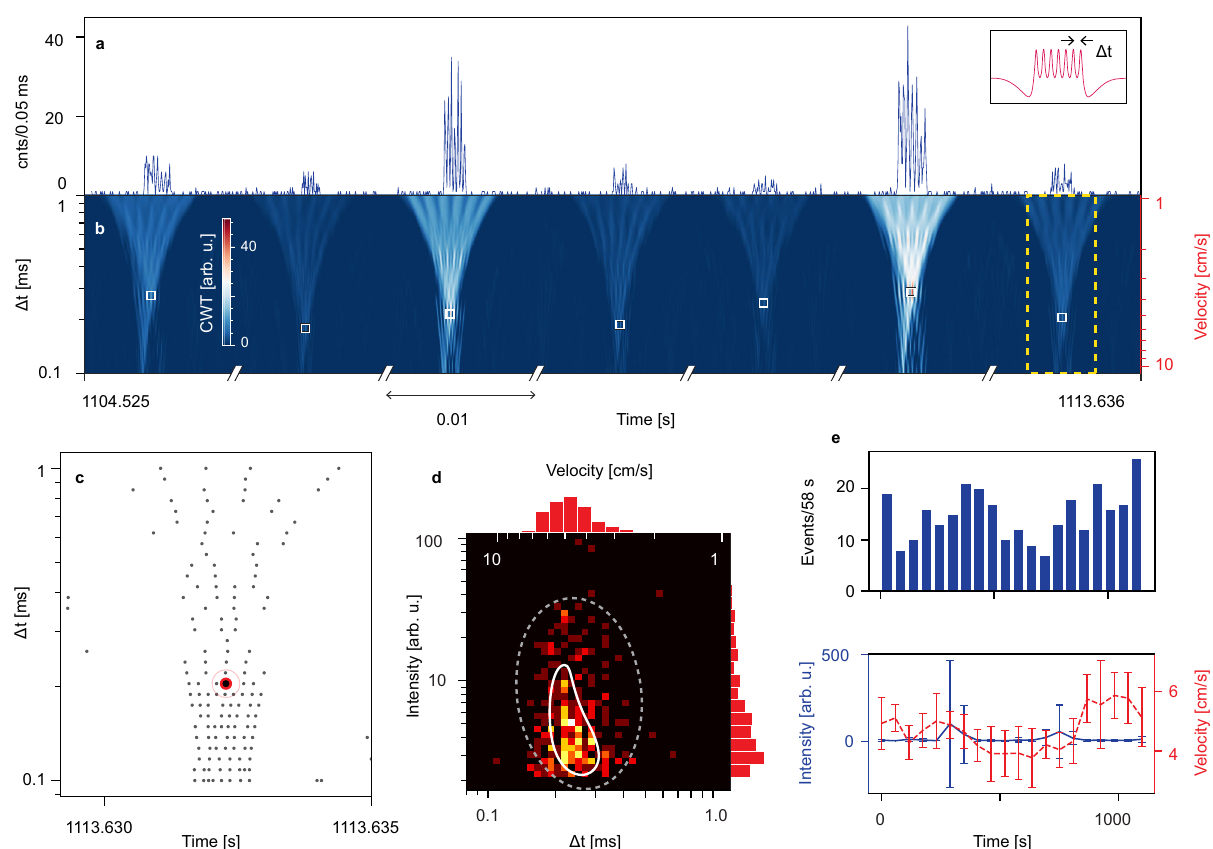
Fig. 4 Multi-peak analysis. a Concatenated 10 ms cuts of detected single KPC molecules in a 9 s window. Inset is the multi-spot Gaussian (MSG) wavelet used to analyze the trace. b Corresponding time- Δ t CWT scalogram with white squares showing detected multi-peak events across a range of Δ t values. c Local maxima for a single example event render conventional ridge-line methods impractical. d Scatter plot for particle intensity and speed, showing a cluster in the predicted region (white line); dashed line: con fi dence region for event identi fi cation as DNA molecules. e Time-varying information of events during the measurement for dynamic determination of the fl ow characteristics. Intensity and velocity plots are the average value for events within a bin from the histogram plot. Error bars represent standard deviation. Table 1 Performance comparison for single-molecule KPC analysis using different